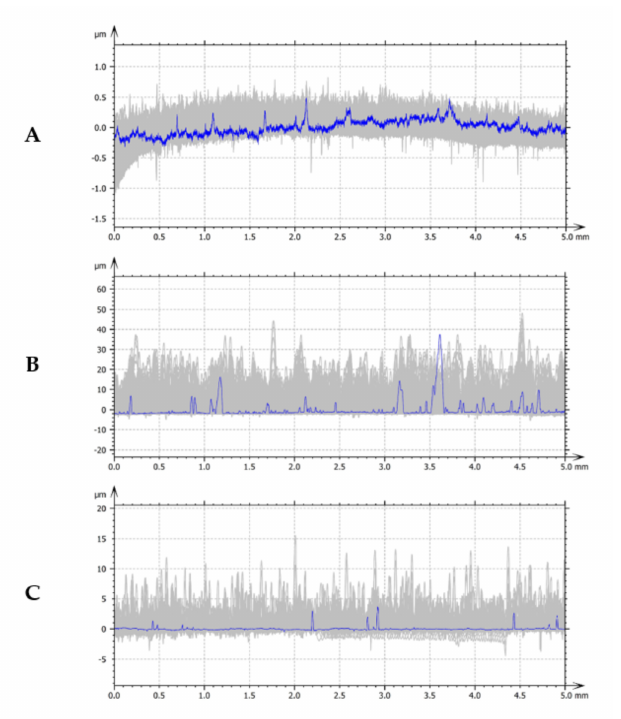
Figure 2. The morphology of the layers: Ni-P/Si 3 N 4 ; ( A ) Ni-P/Si 3 N 4 (2 g/dm 3 ); ( B ) Ni-P/Si 3 N 4 (5 g/dm 3 ).